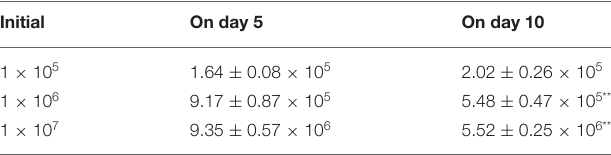
TABLE 2 | Changes in strain JXJ CY 35 T cell densities (CFU/ml) in coculture groups.